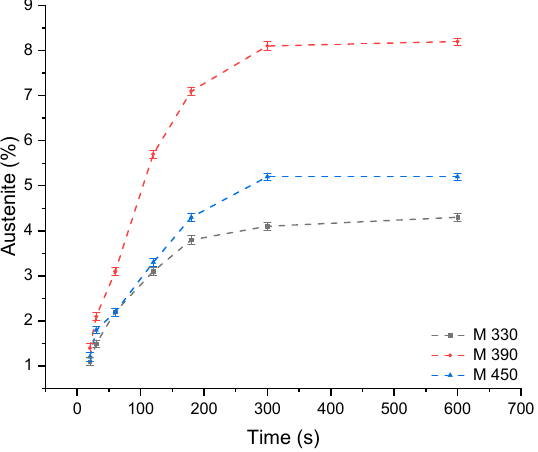
Figure 4. Variation of austenite volume against temperature and soaking time during bainitic isothermal treatments: M 603 K (330 °C), 663 K (390 °C), and 723 K (450 °C).